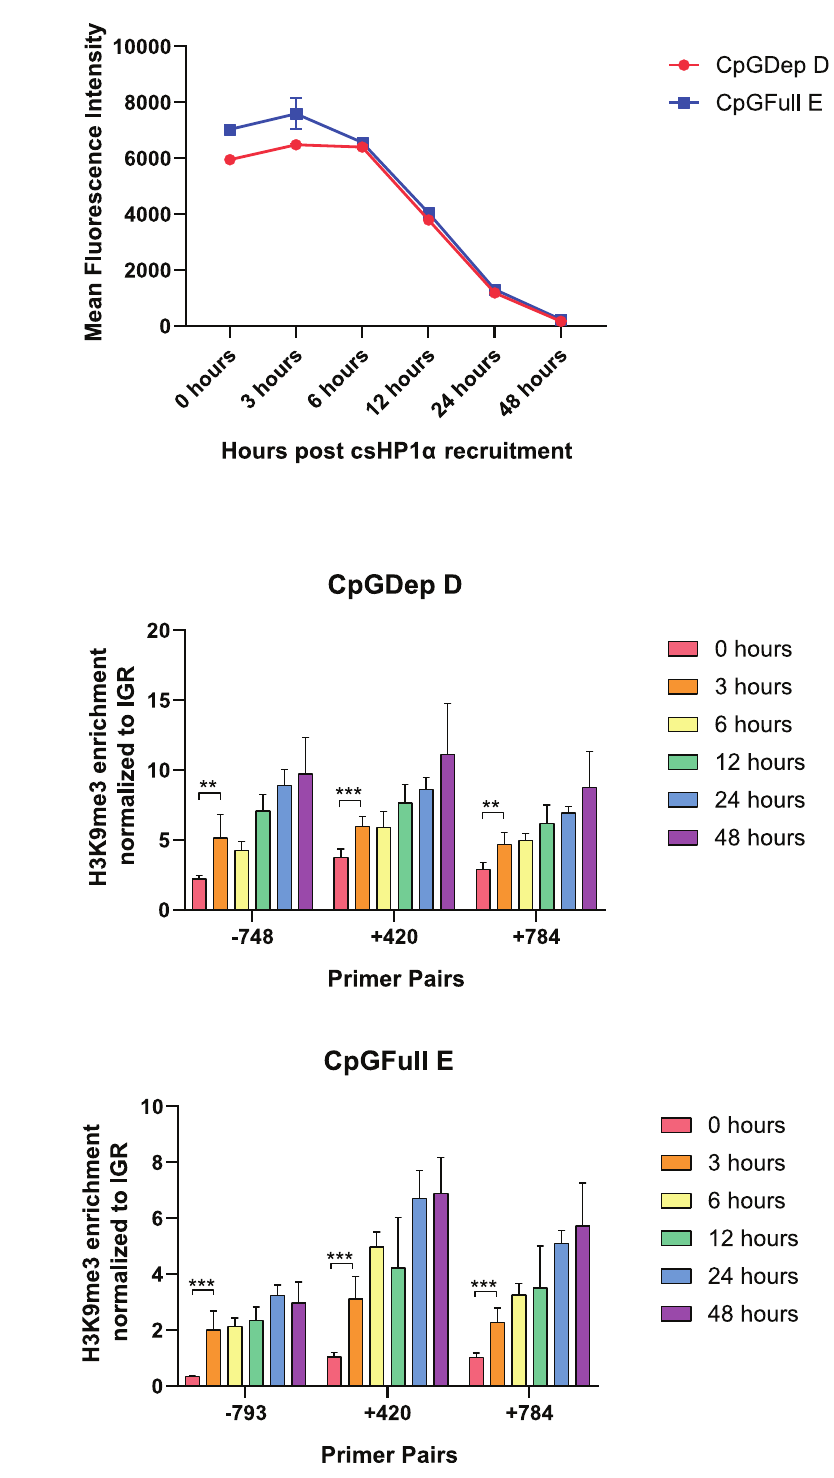
Fig 4. Gene silencing and enrichment of H3K9me3 in two cells lines during 48 hours of CIP. A) Reduction of GFP expression as measured by flow cytometry over a period of 48 hours in CpGDep D and CpGFull E cell lines on Attune 2. B) Relative H3K9me3 enrichment over the first 48 hours of CIP. qPCR primers are the same as used in Fig 3. Each sample contains two biological and three technical replicates, n = 6. �� P � 0.01. ��� P � 0.001. Significant difference between 0 hours and all other timepoints was also found in both cell lines, with all four primer sets. P � 0.01.